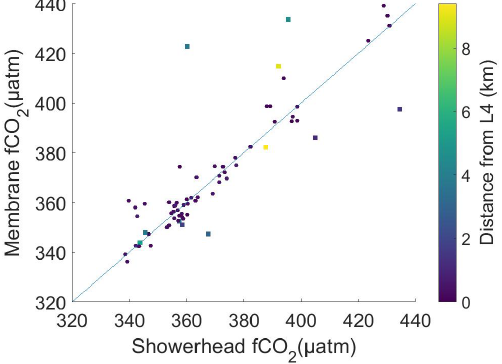
Figure 2. Comparison of coincident seawater f CO 2 measurements made using membrane and showerhead equilibrator systems on the RV Plymouth Quest . Both systems sampled from the underway sea- water supply during transects between L4 and the Plymouth Break- water (filled squares). The ship was stationary for long periods ( > 1h) at L4 (filled circles). The membrane equilibrator system was switched at L4 to tubing connected to a near-surface profiler (Sims et al., 2017) while the showerhead system continued to sample from the underway supply. Data points are coloured as a function of dis- tance from L4 (km). The 1 : 1 line represents perfect agreement and is shown for